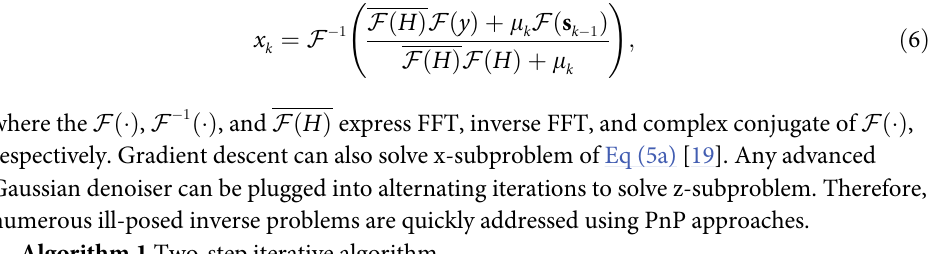
Algorithm 1 Two-step iterative